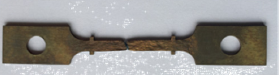
Figure 2. The sample size for the tensile (unit: mm).